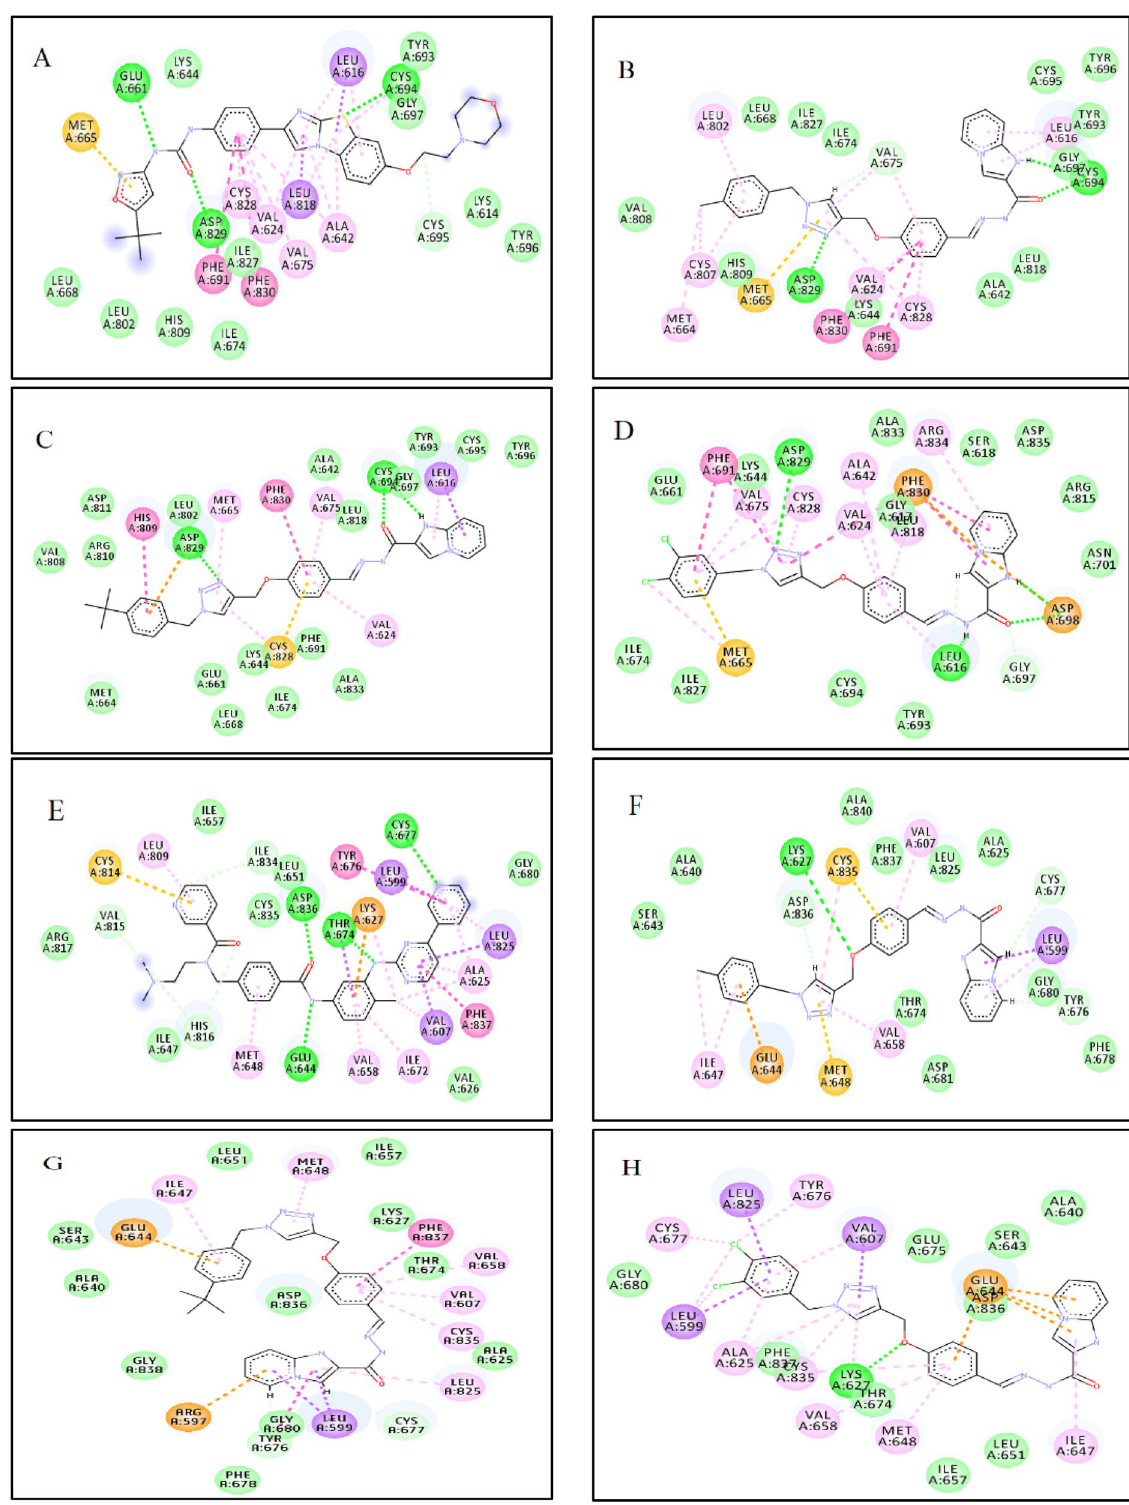
Figure 10. Molecular docking analysis of selected compounds against FLT3 and PDGFRA. 2D Interactions of P30 ( A ), 6d ( B ), 6e ( C ) and 6f ( D ) inside the FLT3 active site (PDB code 4RT7) and 748 ( E ), 6d ( F ), 6e ( G ) and 6f. ( H ) inside the PDGFRA active site (PDB code 5GRN) are shown. Conventional hydrogen bond, pi–sigma, pi–sulfur, pi–pi, and pi–alkyl interactions were colored as green, purple, orange, dark pink and pink, respectively. Images were created by Discovery Studio Client